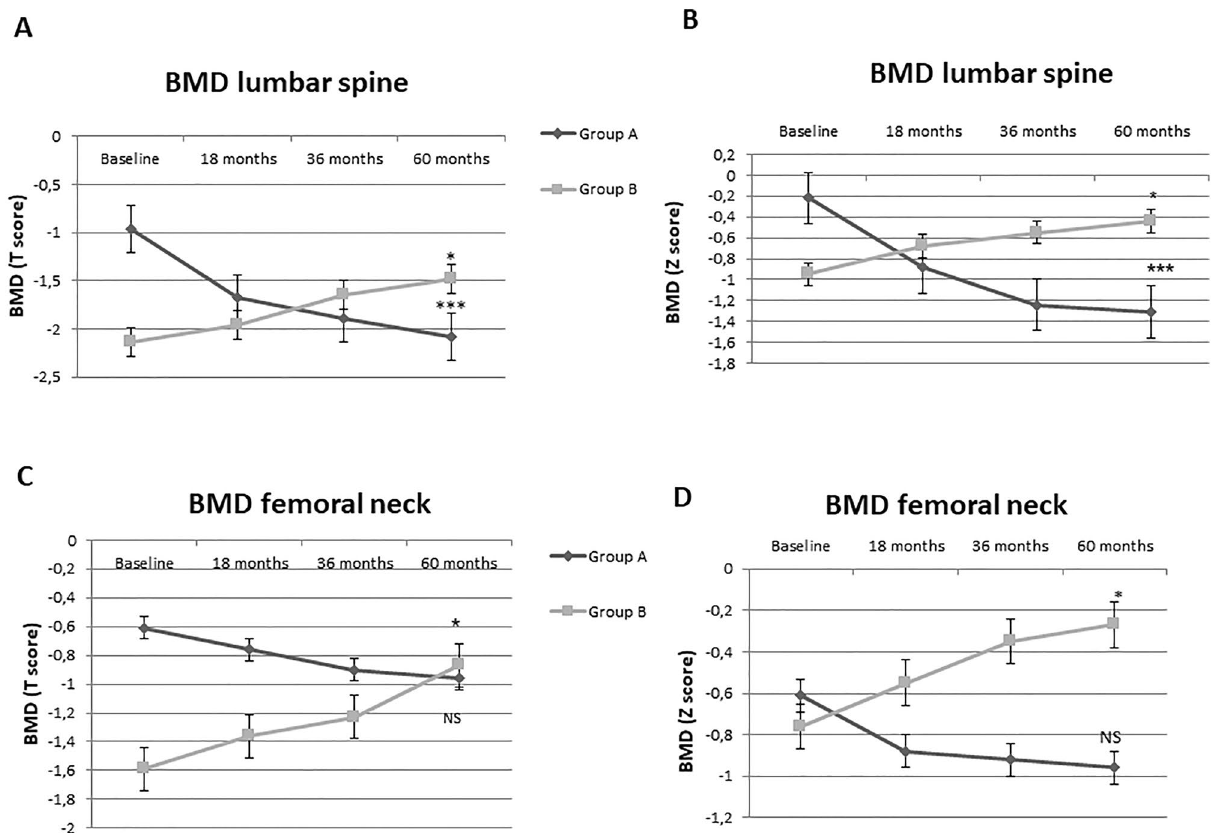
Figure 1. ( A ) Changes in BMD lumbar spine T score from baseline to 60 months for patients of groups A and B. * p < 0.05, ** p < 0.01; *** p < 0.001 versus baseline using the Friedman analysis. Data are means (S.D.). ( B ) Changes in BMD lumbar spine Z score from baseline to 60 months for patients of groups A and B. * p < 0.05, ** p < 0.01; *** p < 0.001 versus baseline using the Friedman analysis. Data are means (S.D.). ( C ) Changes in BMD femoral neck T score from baseline to 60 months for patients of groups A and B. * p < 0.05, ** p < 0.01; *** p < 0.001 versus baseline using the Friedman analysis. Data are means (S.D.). ( D ) Changes in BMD femoral neck Z score from baseline to 60 months for patients of groups A and B. * p < 0.05, ** p < 0.01; *** p < 0.001 versus baseline using the Friedman analysis. Data are means